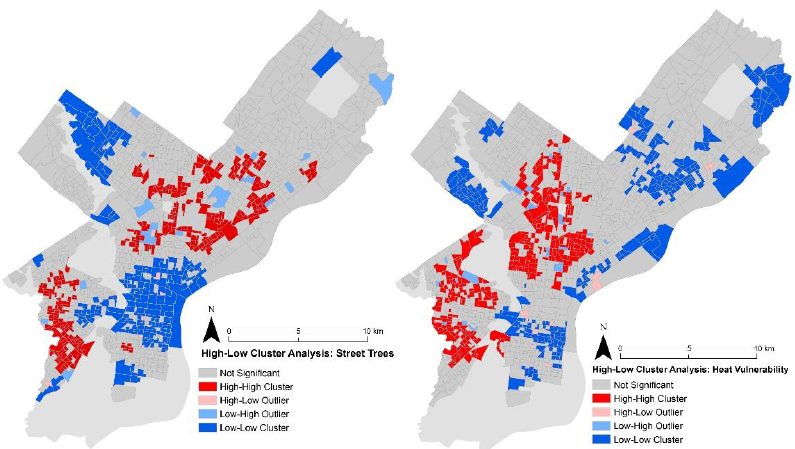
Figure 3. High- low cluster analysis, or Anselin Moran’s I, demonstrating the four types of vulnerability for street trees ( left ) and heat ( right ). Note: the light gray area represents areas of no data.